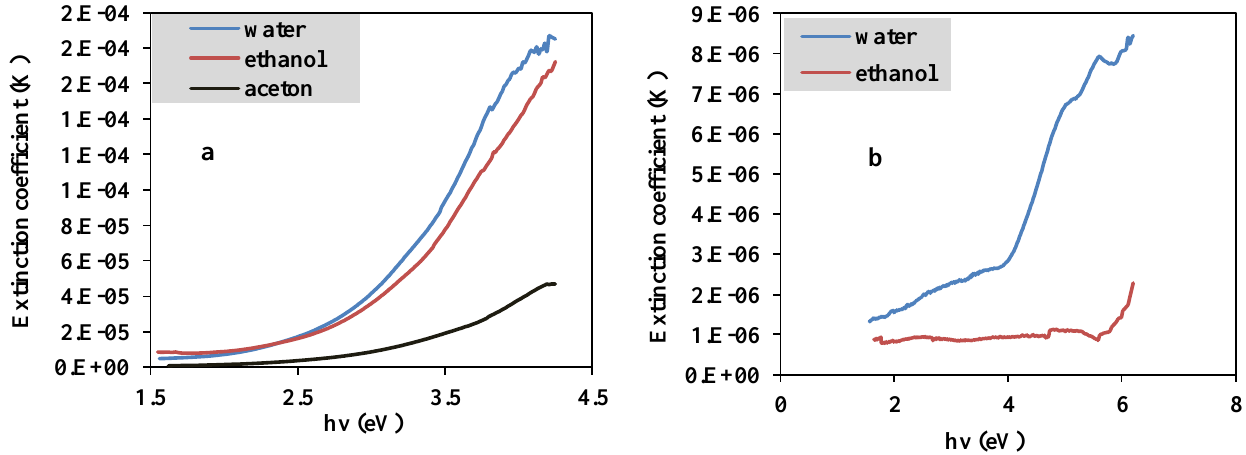
Figure 5: Extinction coefficient (K) of lithium-niobate suspension (a) LN pellet, (b) LN